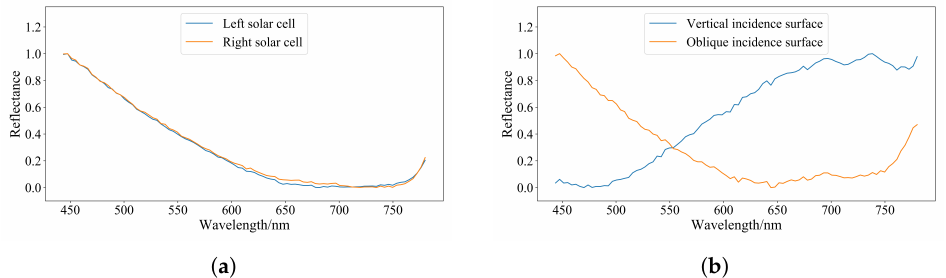
Figure 23. Spectral data distributions of high spatial resolution and negative Z-axis incidence; ( a ) left and right solar cells; ( b ) gold mylar on different surfaces.